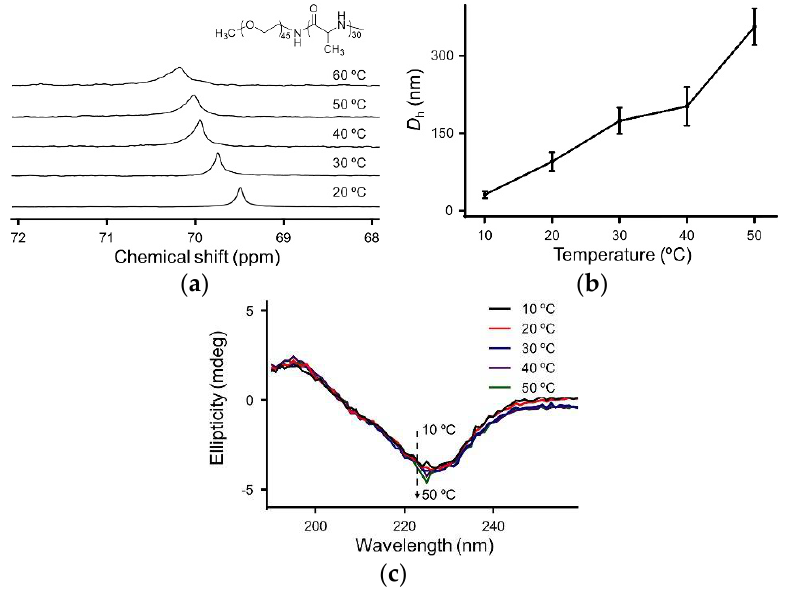
Figure 3. Gelation mechanism of the hydrogels. ( a ) 13 C-NMR spectra (in D 2 O) of 5.0 wt. % mPEG 45 −PLAla 30 solution as a function of temperature; ( b ) Average hydrodynamic diameter (D h ) of micelles of mPEG 45 −PLAla 30 as a function of temperature in water (5.0 μg mL −1 ); ( c ) Circular dichroism (CD) spectra of mPEG 45 −PLAla 30 (0.05 mg mL −1 ) in aqueous solution as a function of temperature.